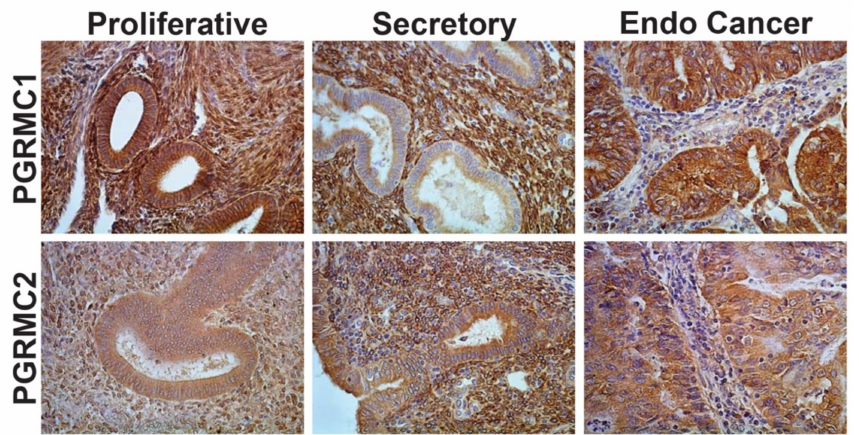
Figure 2. The localization of PGRMC1 and PGRMC2 in human endometrium collected during the proliferative and secretory phases of the menstrual cycle. PGRMC1 and PGRMC2 staining associated with endometrial (Endo) cancer is also shown. These proteins were detected by immunohistochem- istry and are revealed by the brown stain (Pru,